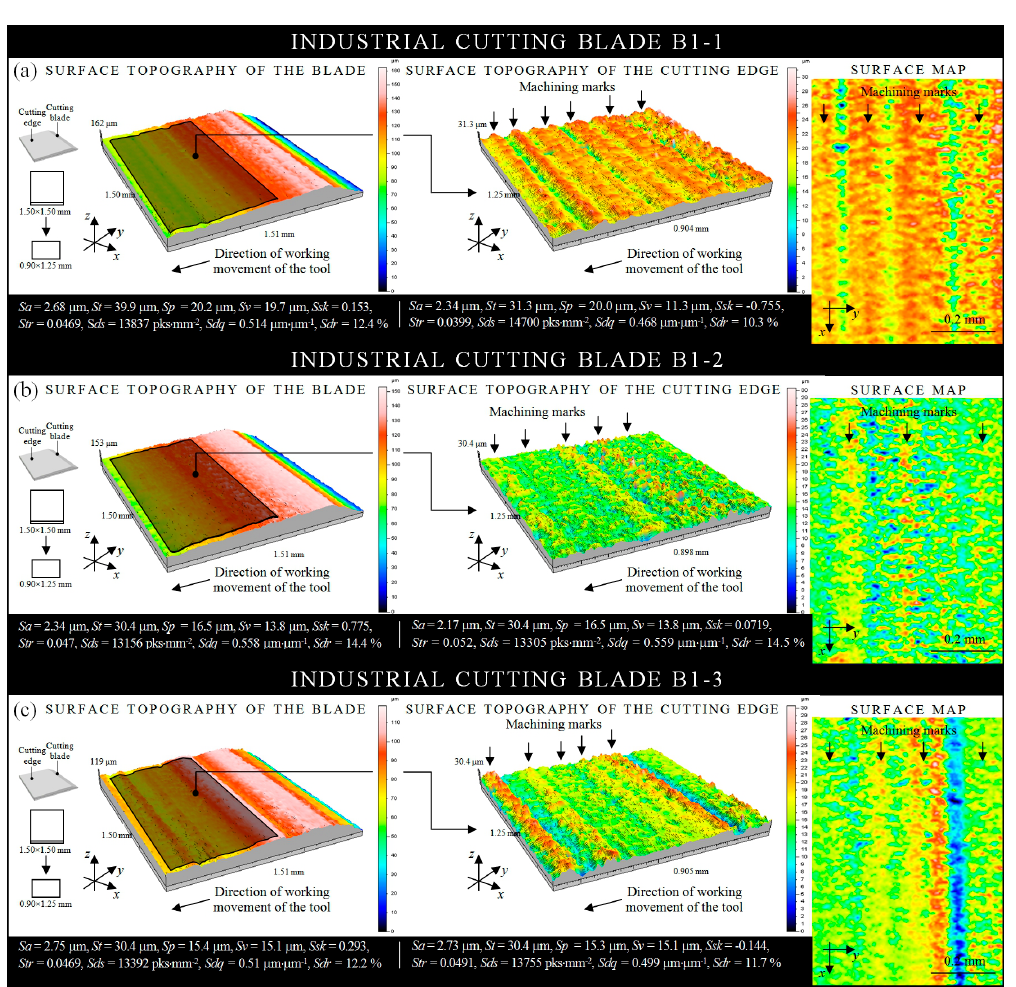
Figure 8. Collection of results of the measurements obtained by the use of multisensory optical profilometer Taylor-Hobson Talysurf CLI 2000 for surfaces of low-stiffness planar industrial cutting blades regenerated by the precision grinding process (peripheral grinding) realized in a 5-axis CNC grinding machine: ( a ) Sample B1-1 ( v w = 300 mm/min, n s = 38,000 min − 1 ); ( b ) sample B1-2 ( v w = 350 mm/min, n s = 38,000 min − 1 ); ( c ) sample B1-3 ( v w = 400 mm/min, n s = 38,000 min − 1 ).